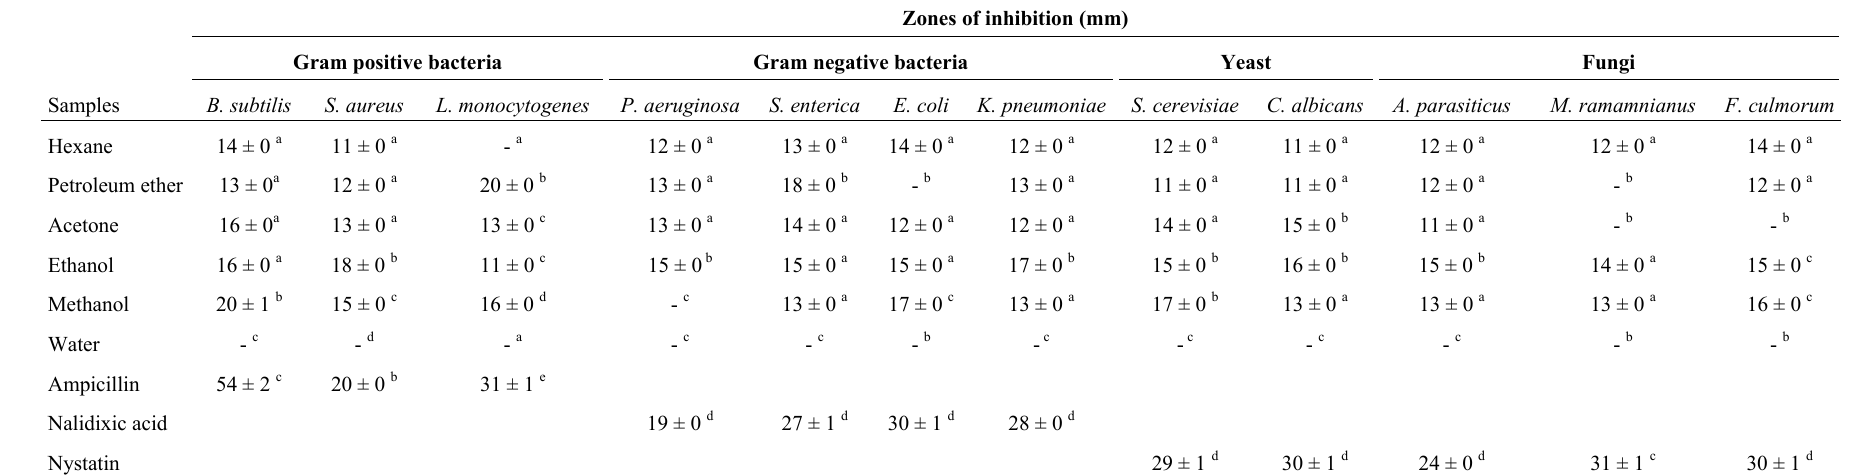
Table 5. Zone of inhibition of microorganisms by E. gillii extracts